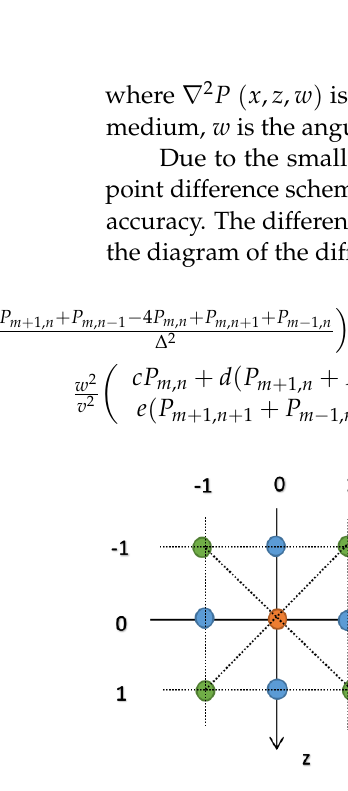
Figure 1. Diagram of the nine-point difference scheme.